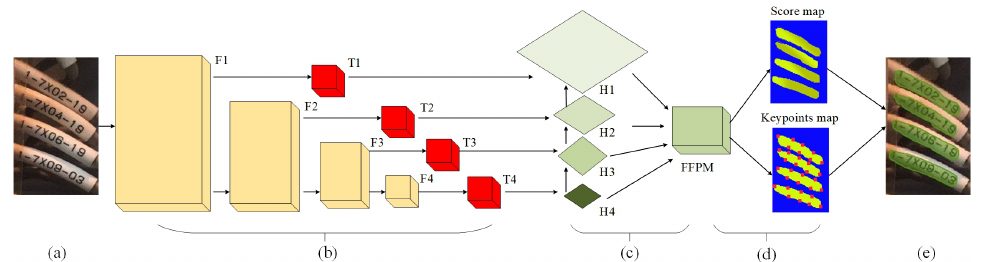
Figure 3. The overall pipeline of detection. ( a ) is the input image with dense scene text. ( b ) At each layer of the feature pyramid network, the Rwin Transformer is adopted to model the rotational invariance of the self-attention mechanism. ( c ) The four layers of the feature pyramid network (FPN) are combined into a new Module (FFPM). ( d ) The module FFPM produces the text score matrix and keypoints matrix. ( e ) We merge the values in the score matrix and keypoints matrix and obtain the final segmentation